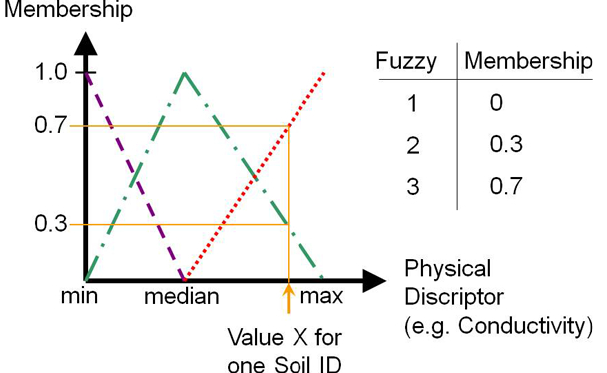
Fig. 3. Example for the definition of the fuzzy numbers for one physical basin descriptor (fuzzy number 1 dashed line; fuzzy num- ber 2 dotted dashed line; fuzzy number 3 dotted line).